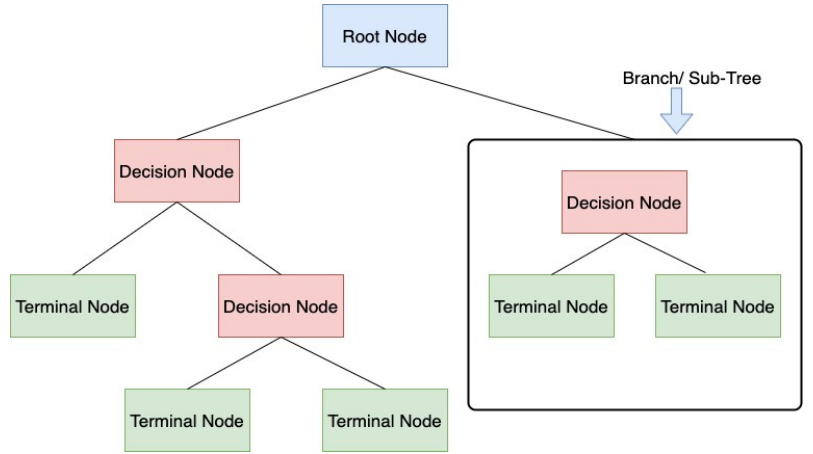
Figure 8. Decision Trees classification scheme.